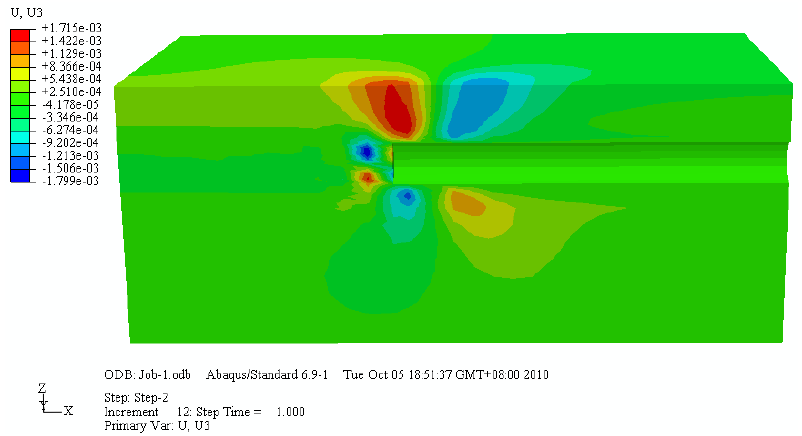
Figure 15. Vertical ground movement clouds of the model under additional friction force (m).